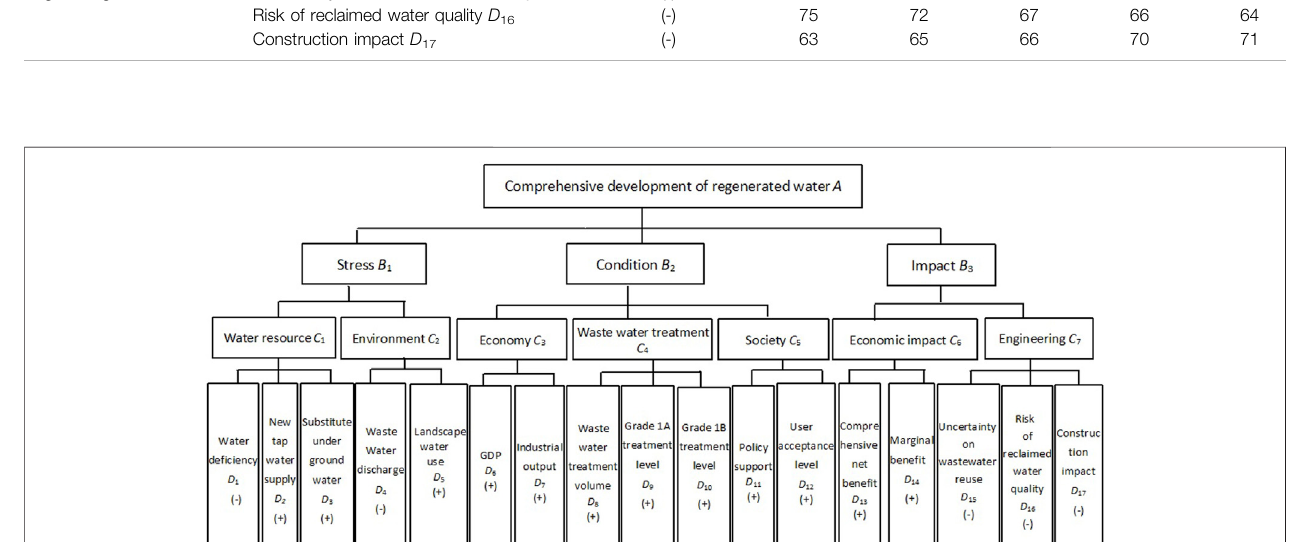
FIGURE 2 | Matrix system for assessment of comprehensive development of reclaimed water.